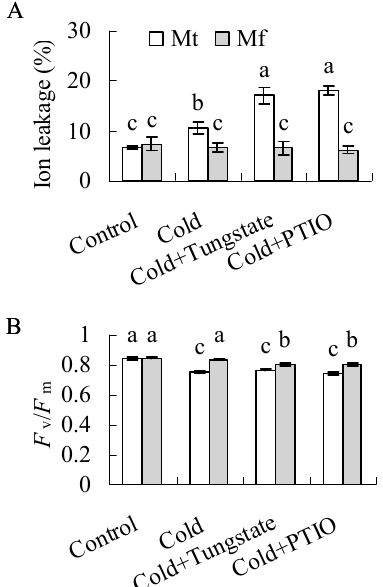
Figure 2. Ion leakage ( A ) and maximum photochemistry efficiency of photosystem II ( F v / F m , B ) in M. falcat a (Mf) in comparison to M. truncatula (Mt) as affected by tungstate and PTIO after cold treatment. Ten-week-old M. falcata and M. truncatula cv. A17 plants were irrigated with 15 mL of 1 mM tungstate or 100 µ M 2-phenyl-4,4,5,5,-tetramethylimidazoline-1-oxyl 3-oxide (PTIO) solution or H 2 O as a control, followed by exposure to 5 ◦ C in a growth chamber for 21 d. Means of three replicates and standard errors are presented; the same letter above the column indicates no significant difference Int. J. Mol. Sci. 2019 , 20 , x within each day at p < 0.05.